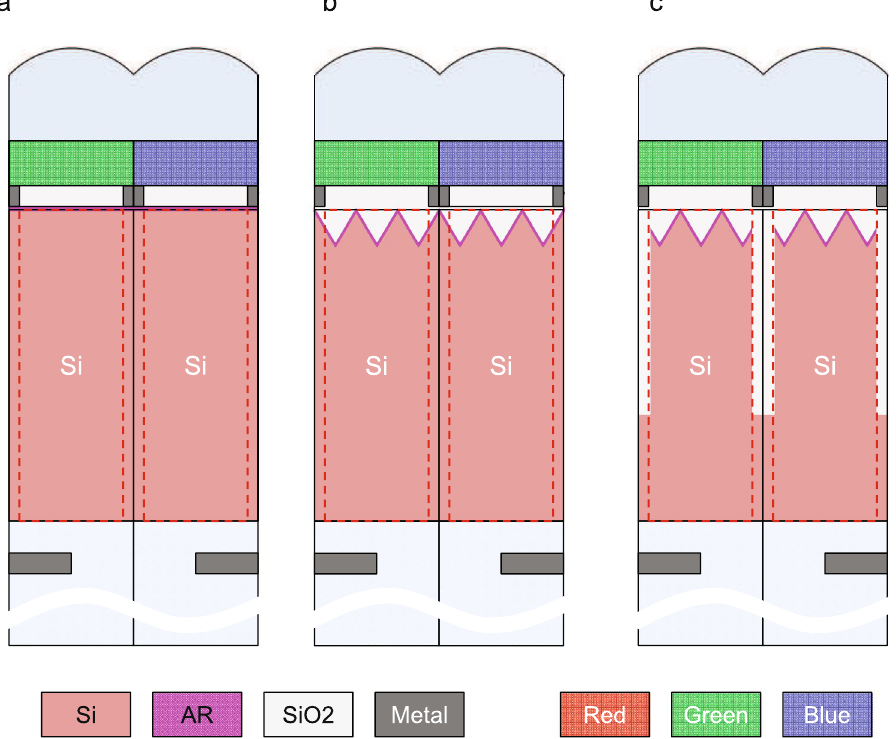
Figure 3. ( a ) A schematics of the reference sample which has flat Si surface with AR coating (Sample A). The thickness of Si photo detector is 3 μ m. The on-chip micro lens height is 1.7 μ m from the Si surface to the top with the curvature radius of 0.85 μ m. Each pixel equips on-chip color filter whose thickness of 0.5 μ m. ( b ) A schematics of Sample B, which is same as Sample A, but with the IPA structure with the pitch of 400 nm, so that each pixel contains 3 × 3 IPA. ( c ) A schematics of Sample C which is same as Sample B except the DTI whose width of 200 nm and depth of 2000